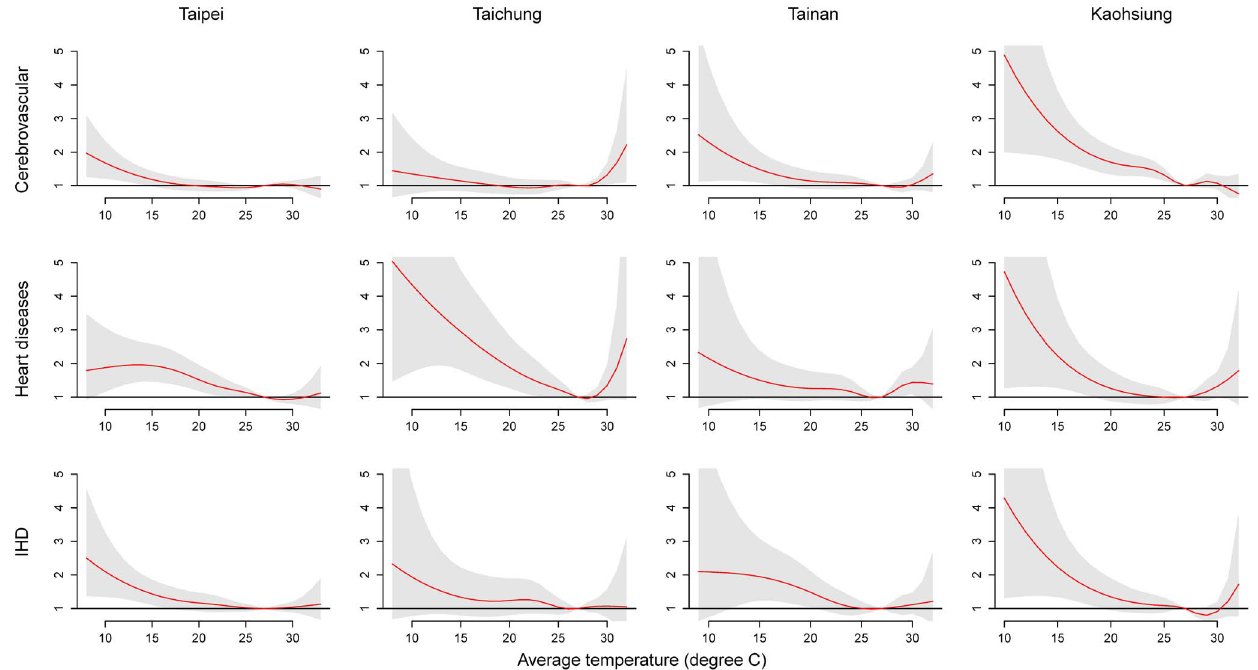
Figure 3. Associations between mortality from cerebrovascular diseases, heart diseases, and ischemic heart disease and daily average temperatures in metropolitans Taipei, Taichung, Tainan, and Kaohsiung during 1994–2007. Cumulative 21-day (lag 0 to 20) RRs were estimated using DLNM with a centered temperature of 27 u C.